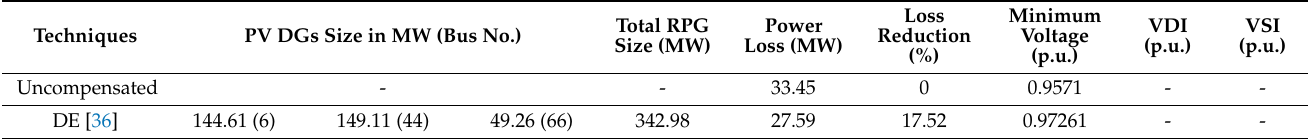
Table 10. Comparative study between the proposed system and Algerian transmission system. Techniques PV DGs Size in MW (Bus No.)